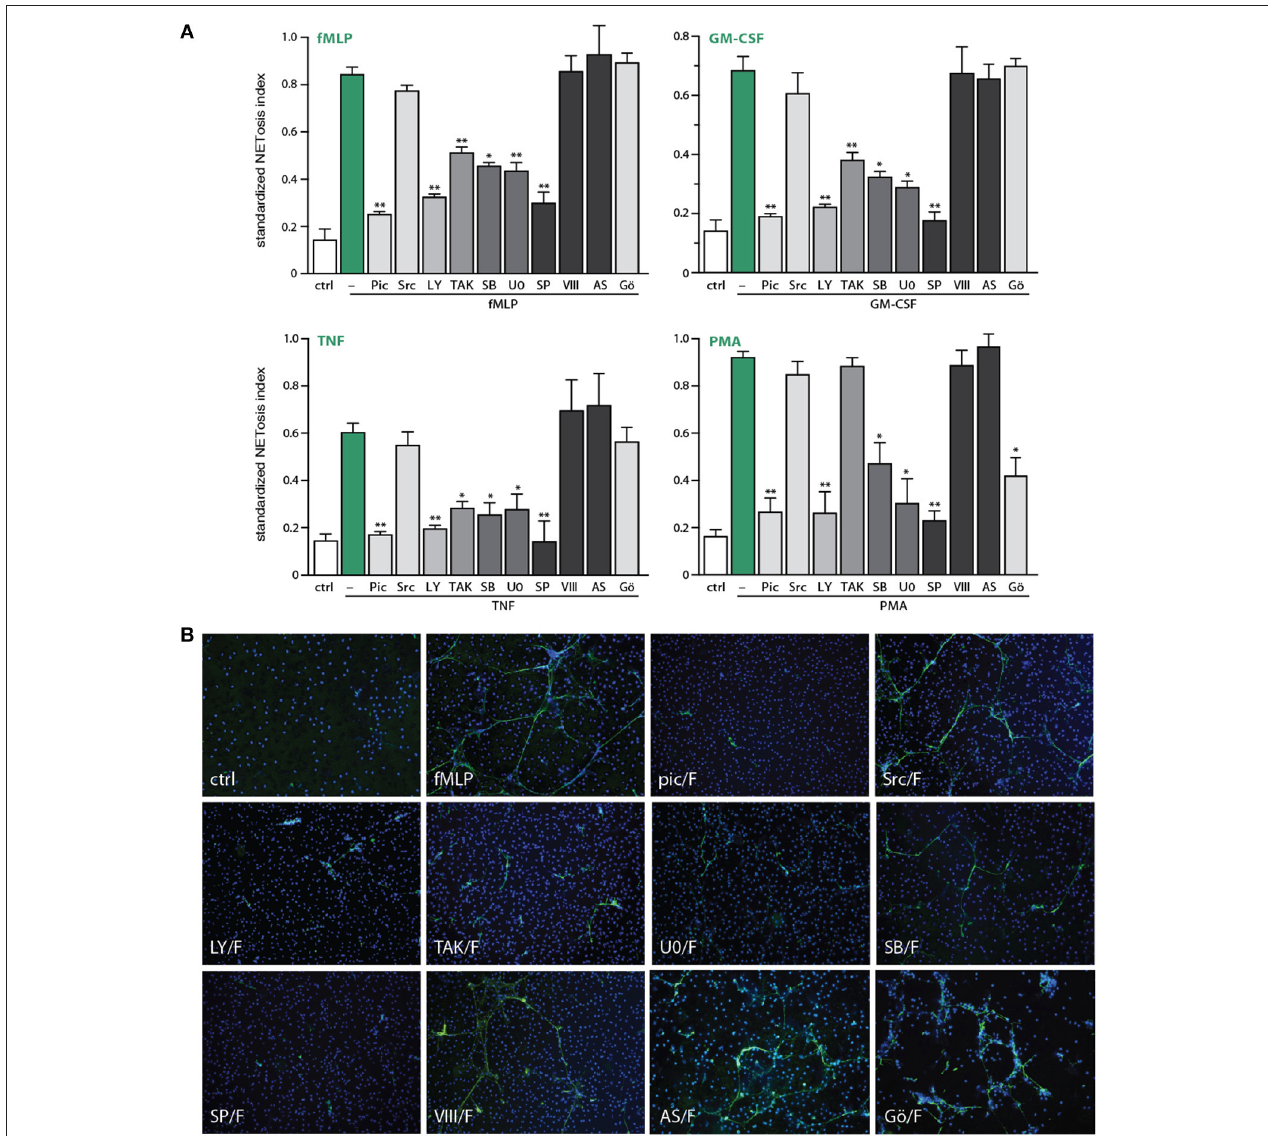
FIGURE 4 | Signaling pathways controlling NETosis induced by physiological neutrophil agonists or PMA. Neutrophils cultured on poly-L-lysine-coated coverslips were pre-treated (15min, 37 ◦ C) with the following inhibitors or their diluent (DMSO): 10 µ M piceatannol (Syk inhibitor); 10 µ M SrcI1 (Src family kinase inhibitor); 10 µ M LY294002 (PI3K inhibitor); 1 µ M (5Z)-7-oxozeaenol (TAK1 inhibitor); 1 µ M SB202190 (p38 MAPK inhibitor); 10 µ M U0126 (MEK inhibitor); 10 µ M SP600125 (JNK inhibitor); 10 µ M JNK inhibitor VIII (a different JNK inhibitor); 5 µ M AS601285 (a third JNK inhibitor); 10 µ M Gö6976 (a PKC inhibitor). The cells were then further incubated for 4h in the absence (“ctrl”) or presence of 30nM fMLP, 1nM GM-CSF, 100 U/ml TNF α , or 50nM PMA. NETosis was assessed using PlaNET Green as described in Methods . (A) Quantitative representation of these experiments, expressed as NETosis index. Mean ± s.e.m. from at least 3 independent experiments. * p < 0.05 and ** p < 0.01 vs. stimulus alone. (B) Representative fields for each experimental condition are shown at 10X